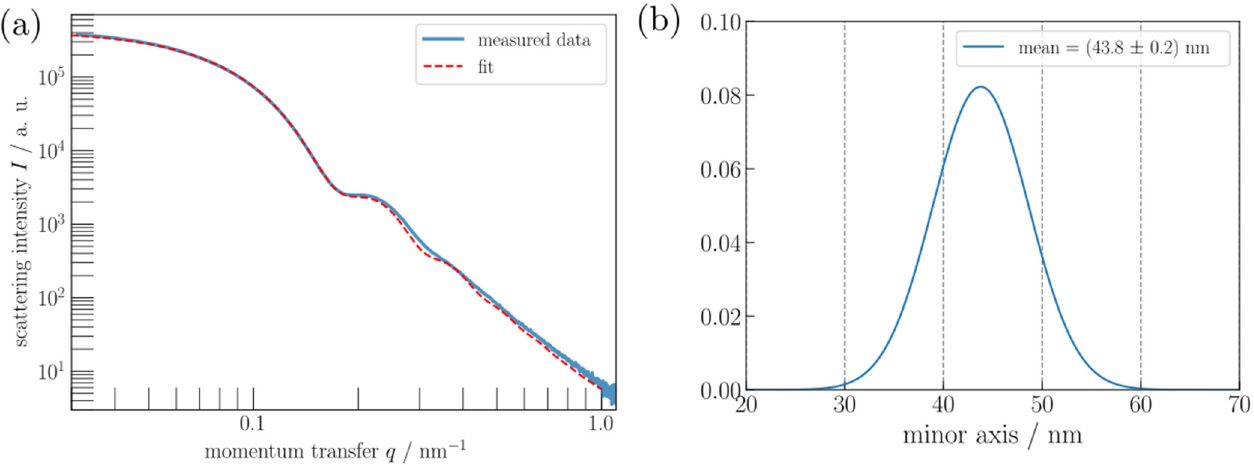
Figure 14. ( a ) SAXS: Fit of the measured data of the TiO 2 bipyramids assuming the aspect ratio of the truncated bipyramids given in Table 4 for orientation ② . ( b ) Number ‐ weighted distribution of the minor axis of the TiO 2 bipyramids.